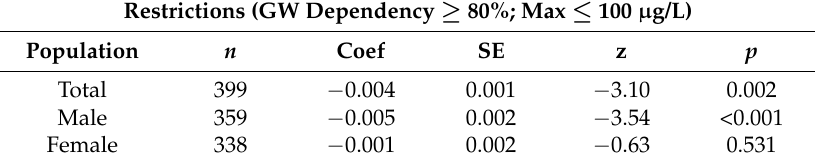
Table 4. Adjusted Poisson log-linear model with ≥ 80% dependency and maximum arsenic <100 µ g/L.